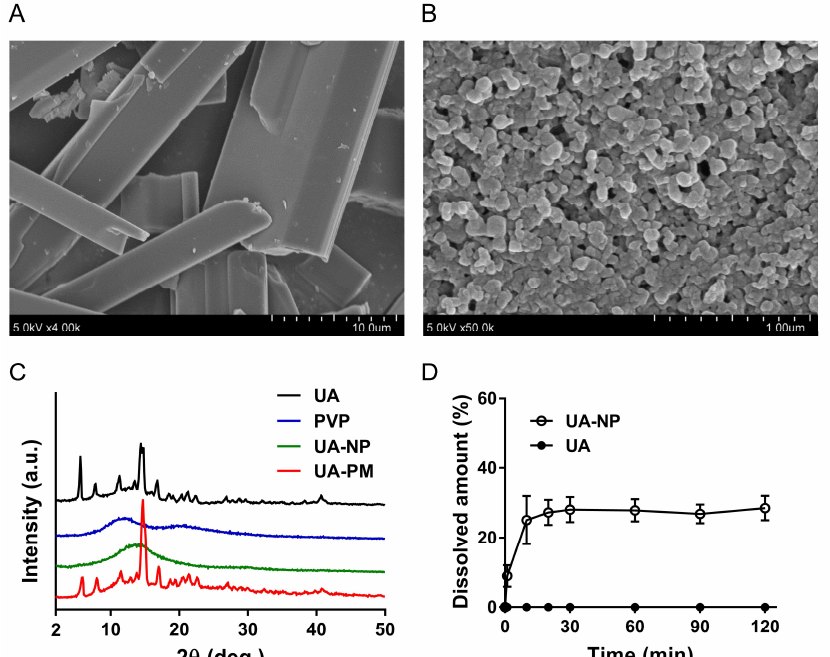
Figure 4 Figure 4. Physicochemical properties of UA nanoparticles (UA-NP). ( A ) Field emission scanning electron microscopy (FESEM) photograph of non-formulated UA (magnification: 4000 × ; scale bar = 10.0 µ m). ( B ) FESEM photograph of nanoformulated UA (magnification: 50,000 × ; scale bar = 1.0 µ m). ( C ) X-ray diffraction patterns of UA, polyvinylpyrrolidone (PVP), nanoformulated UA nanoparticles (UA-NP), and UA-PVP physical mixture (UA-PM). XRD patterns were taken from 2 ◦ to 50 ◦ with a scanning rate of 4 ◦ /min. The spectra were offset for clarity. ( D ) Drug dissolution test (open circle, UA-NP; filled circle, UA). Samples containing 4.68 mg equivalent of UA were placed in 100 mL of pH 7.4 phosphate buffer and maintained at 37 ± 0.5 ◦ C. During the dissolution process, samples were withdrawn at 0, 1, 10, 20, 30, 60, 90 and 120 min for HPLC analysis. Data points are expressed as means ± SD ( n =